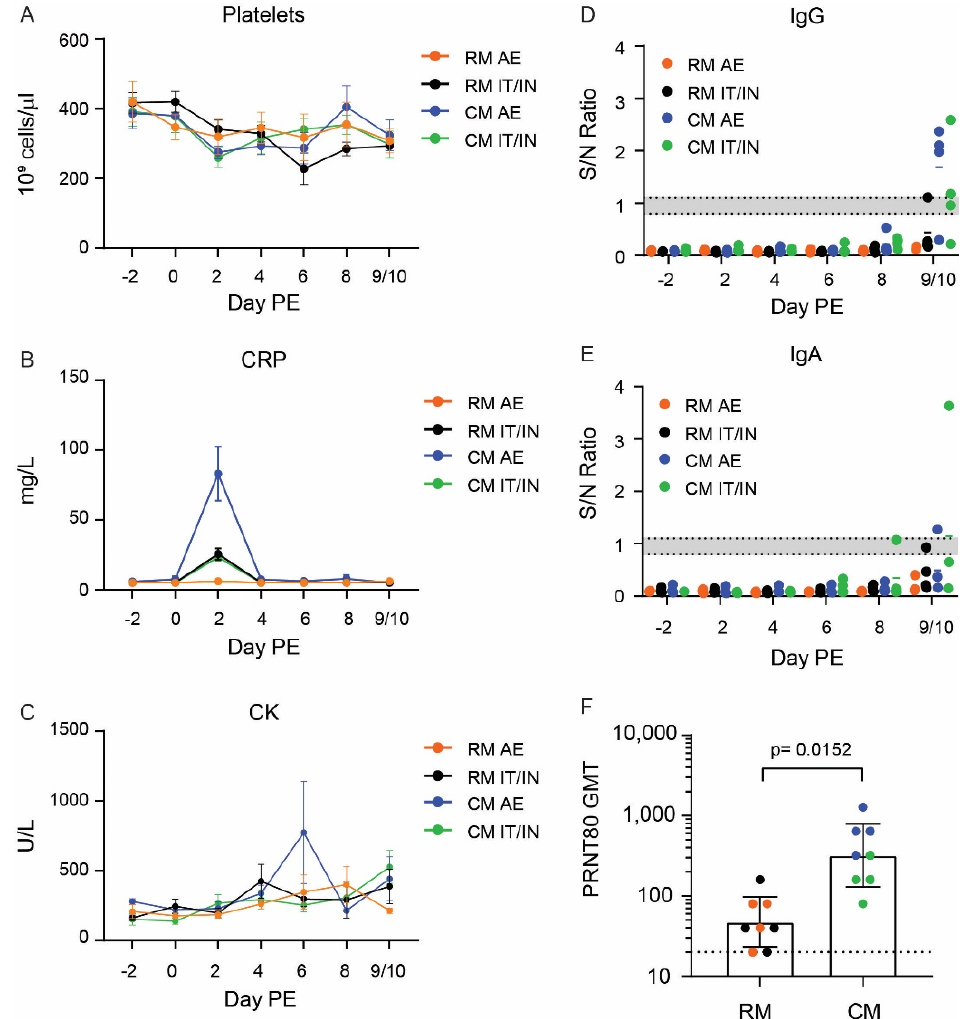
Figure 5. Clinical pathology and serological responses to SARS-CoV-2 in rhesus (RM) and cynomolgus macaques (CM) infected by aerosol (AE) or intratracheal/intranasal (IT/IN) exposure. ( A – C ) Levels of platelets ( A ), CRP ( B ), and CK ( C ) over the course of the study. Data are shown as the mean ± SEM. Graphs of individual data points can be found in Figure S8. IgG ( D ) and IgA ( E ) results from the EUROIMMUN SARS-CoV-2 ELISA kits. Results are shown as the signal-to-noise (S/N) ratio. The bottom and top dotted lines represent the assay cutoffs for negative and positive results, respectively, with the gray shaded region representing indeterminate results. The mean is denoted by a colored dash for each group. ( F ) PRNT 80 geometric mean titer (GMT) for RM versus CM in serum obtained at the terminal time point (Day 9 or 10 PE), with each animal represented as a dot and color corresponding to experimental group. The dotted line represents the assay cutoff for positive results (PRNT 80 of 20). Error bars represent the geometric SD. Statistical significance was determined using an unpaired t test.